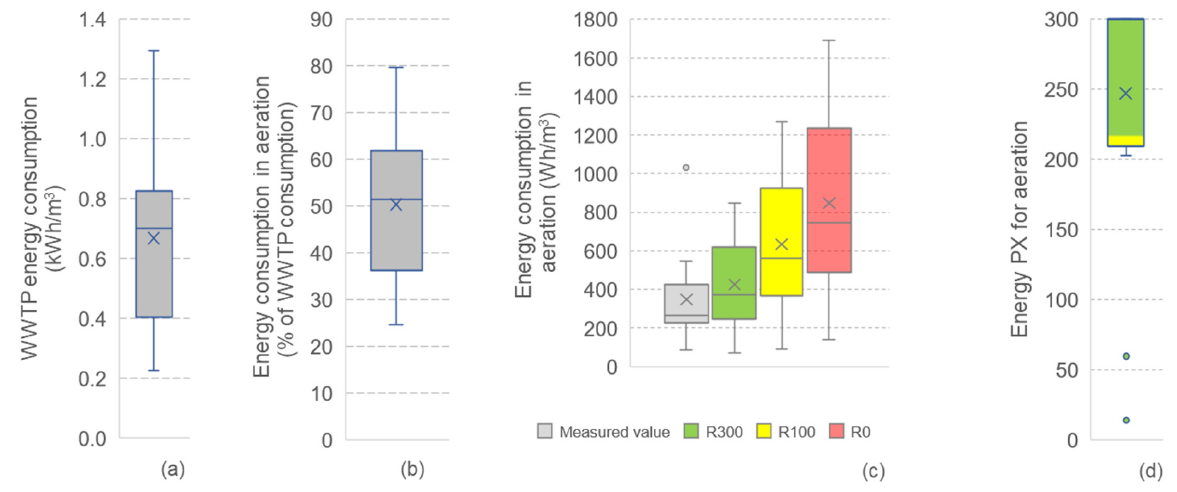
Figure 6. The energy consumption in the iEQTA WWTPs ( a ) and in aeration ( b , c ), the computed reference values ( c ), and the performance indices for aeration ( d ).